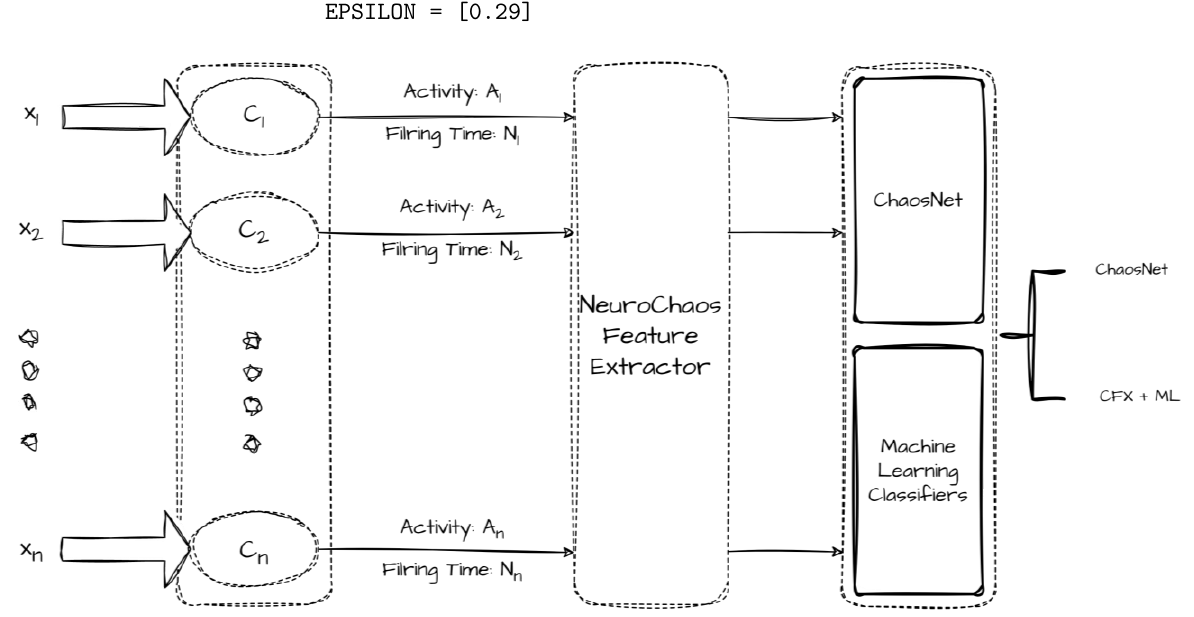
Figure 3. Architecture proposing Conjunction of the Chaos Feature Extractor with standard ML classifiers. The three actions involved include feature transformation, feature extraction from neurochaos, and classification in the first two steps. ChaosNet or any other ML classifier could be selected as the chosen classifier. One-dimensional Generalized Lüroth Series (GLS) neurons make up the initial tier of the feature transformation unit. These are tiny-bit linear chaotic maps. More details regarding this architecture can be obtained from the works by Deeksha Sethi, Nithin Nagaraj, and Harikrishnan N.B. (Sethi et al. 2023) .